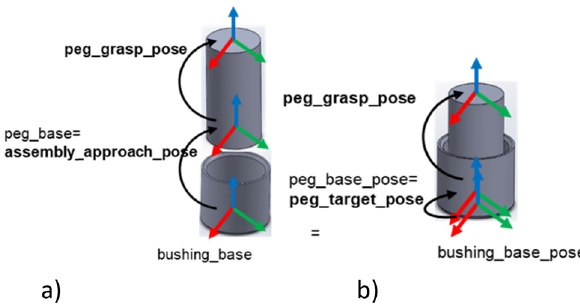
Figure 5: Assembly knowledge as approach and grasp poses in part coordinate frames, for a grasped peg before ( a ) and after ( b ) assembly